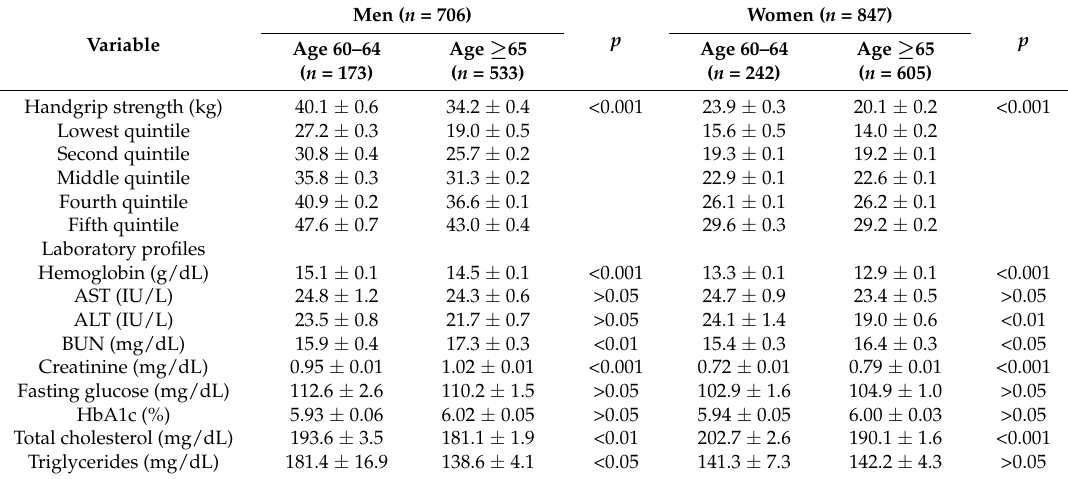
Table 2. Handgrip strength, laboratory data, and nutritional status of study subjects.